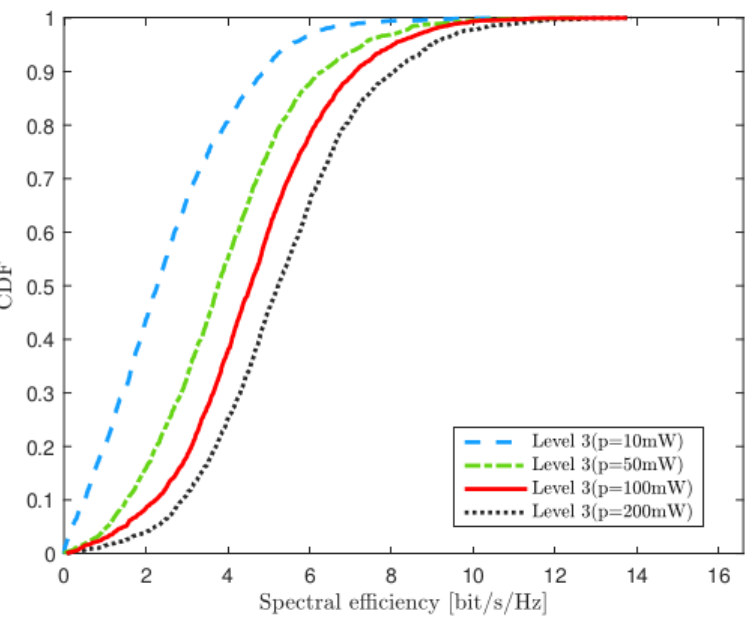
Figure 7. The SE comparison under different uplink transmit